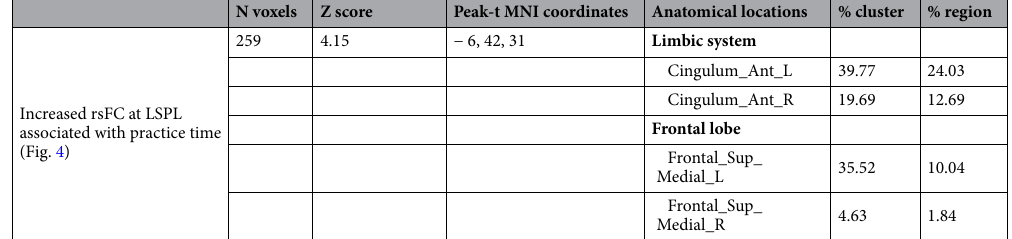
Table 2. Summary of cluster-level statistics for clusters showing significant longitudinal changes after meditation practice. MNI : Montreal Neurological Institute. † A voxel-level statistical threshold of P < 0.005 was used.